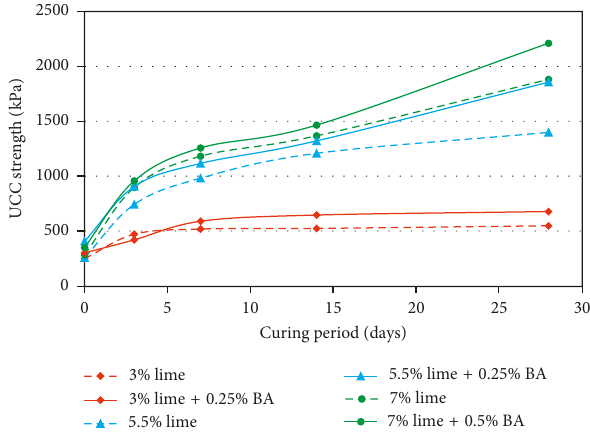
Figure 6: Comparison of UCS with curing period of lime stabilized soil with and without